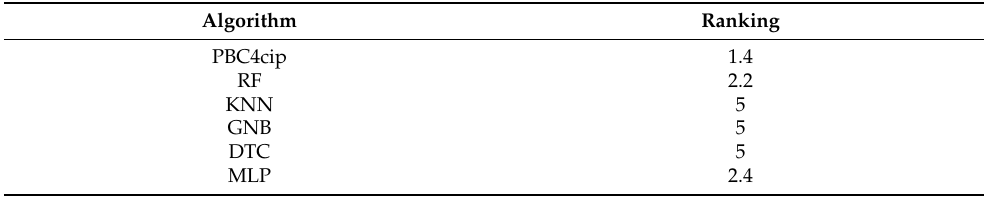
Table 6. Average Rankings of the algorithms (AUC).